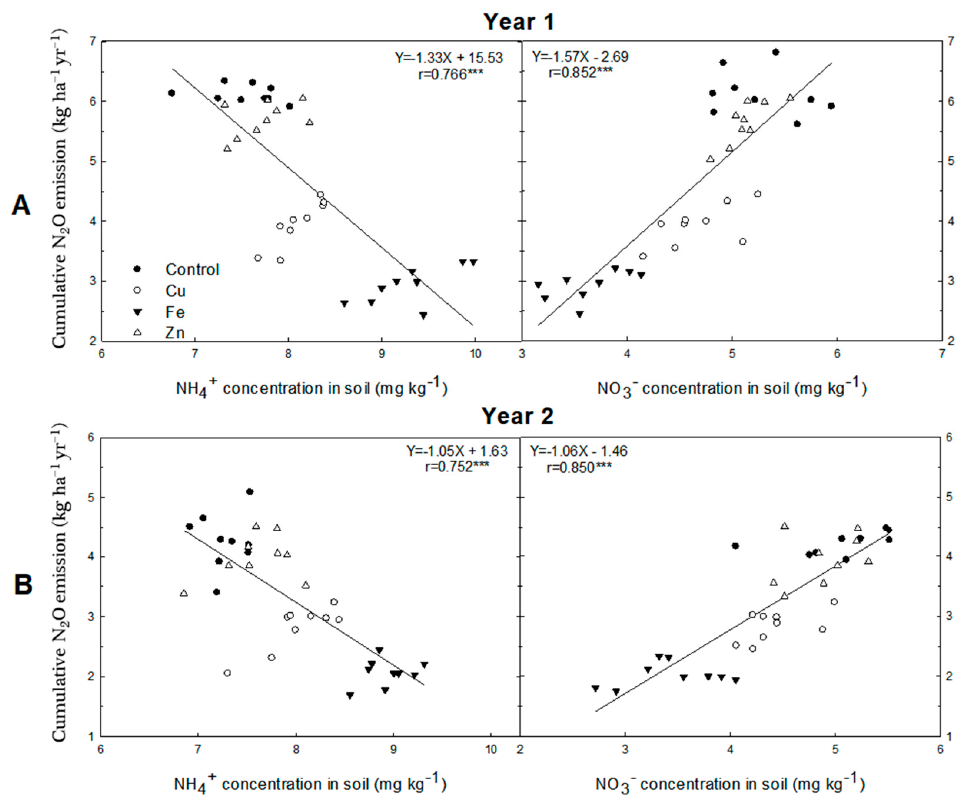
Figure 3. Relationships between cumulative nitrous oxide (N 2 O) emissions and ammonium (NH 4+ ) and nitrate (NO 3 − ) concentrations in soil at harvest in Year 1 ( A ) and Year 2 ( B ). *** Significant at p < 0.001 level.